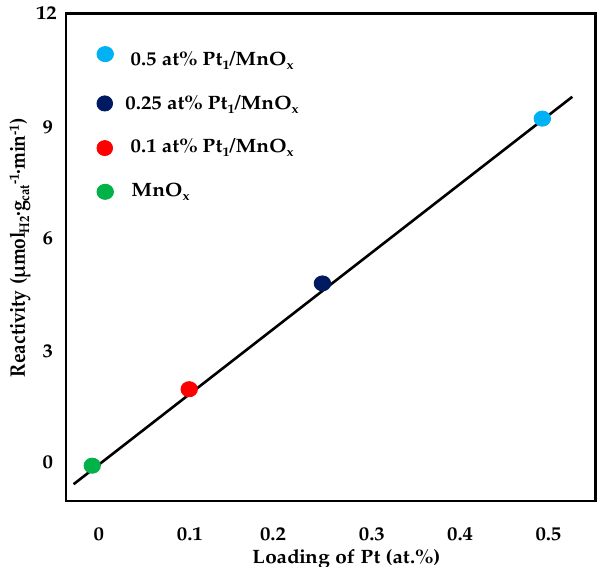
Figure 13. Reactivity of WGS as a function of platinum loading, adapted from [86], with permission from American Chemical Society, 2018; T = 200 °C, 10% CO, 3% H 2 O, 87% He (linear fitting with R 2 = 0.9988).